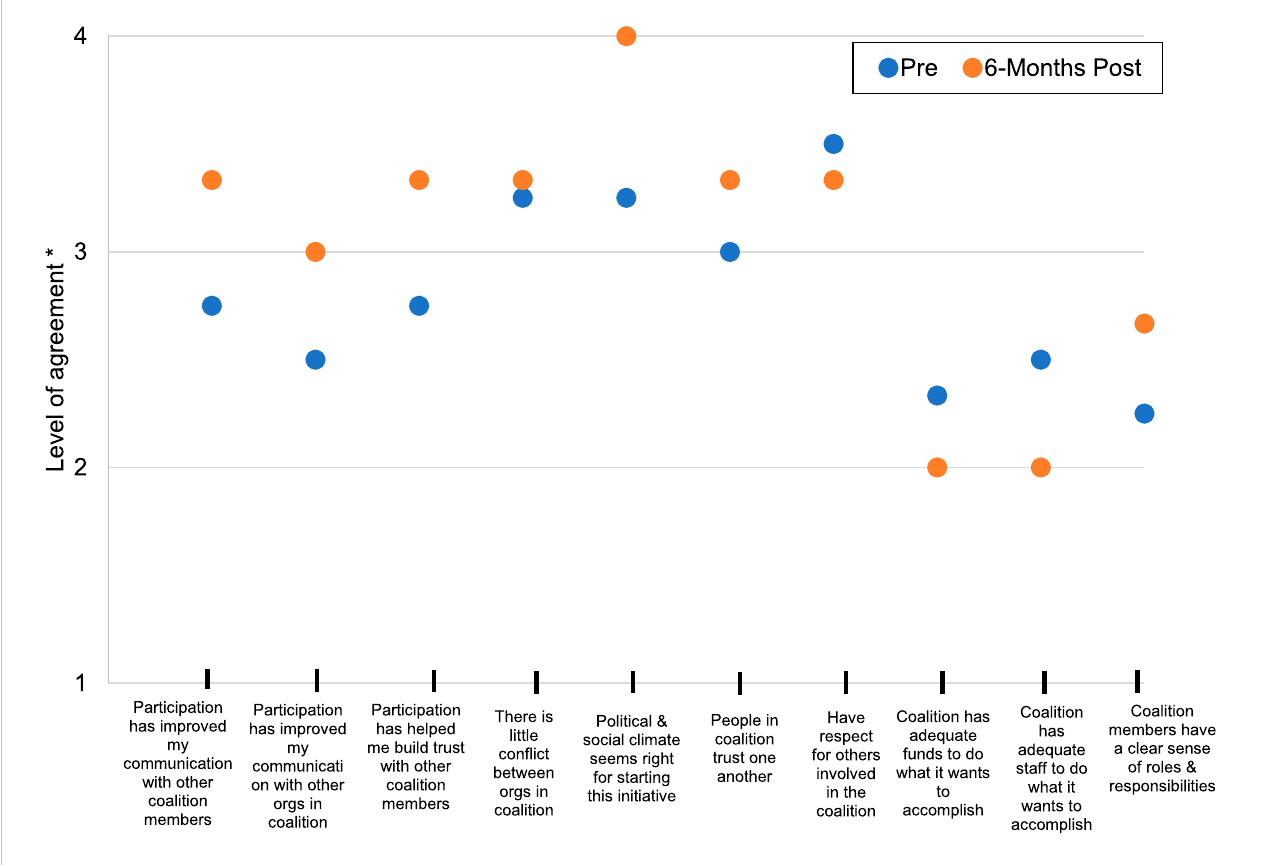
FIGURE 5 Team-speci fi cchangeinperceivedcoalitioncommunication,trust, climate,andresourcesbetweenVisionZeroLeadershipInstituteand6-month post-